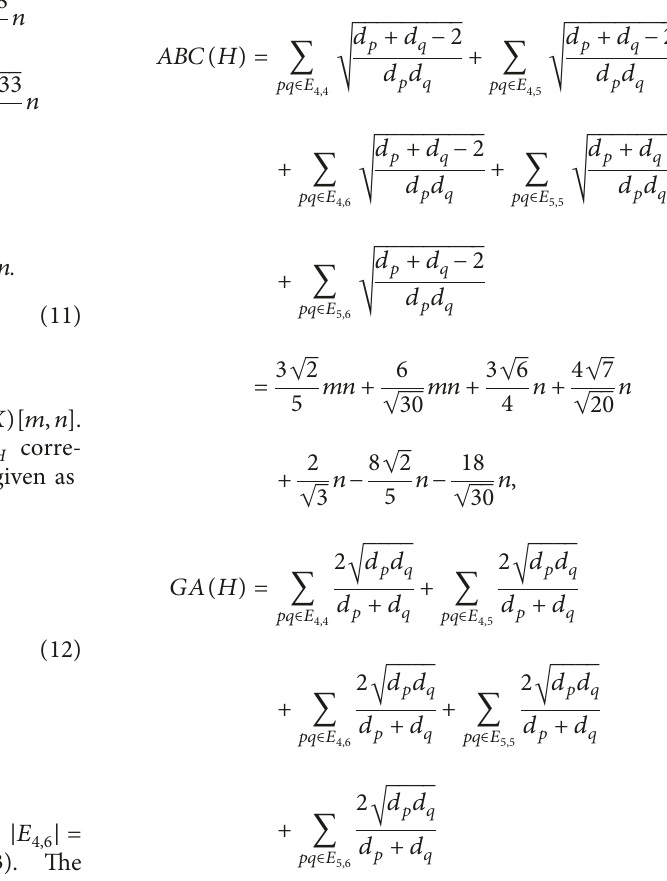
Figure 4. From (2) and (4), the ABC and GA indices of H are